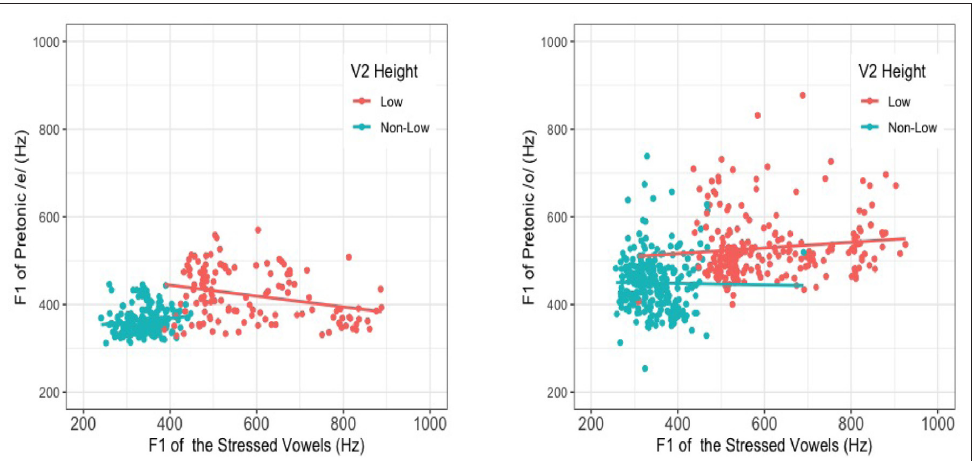
Figure 7: Correlation between stressed F1 (Hz) and pretonic F1 (Hz) for tokens produced by NE-D speakers, with pretonic /e/ on the left, and pretonic /o/ on the right.